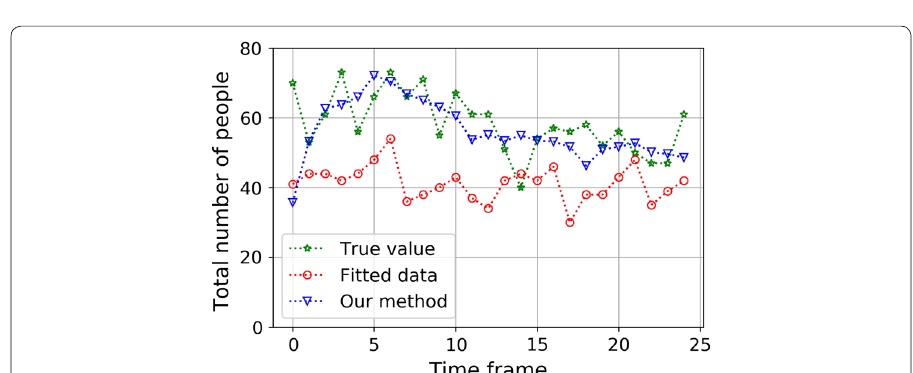
Fig. 11 An overview of performance through time for one simulation